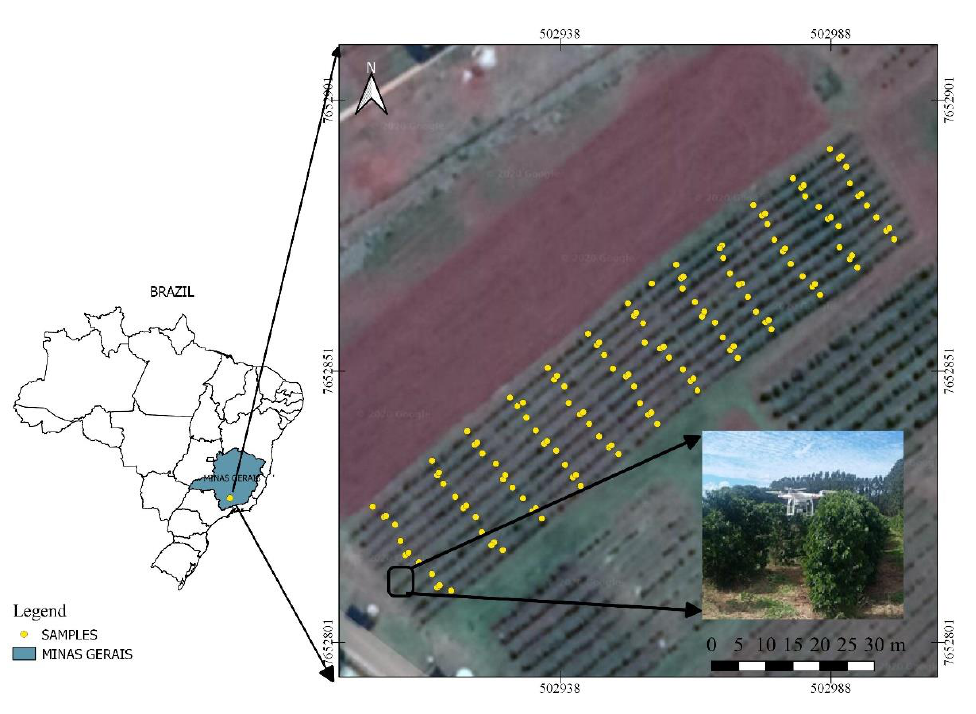
Figure 1. Location of the study area.